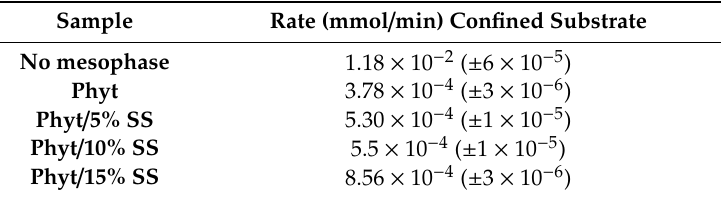
Table 2. Enzymatic reaction rates expressed in mmol / min of converted substrate for the free substrate